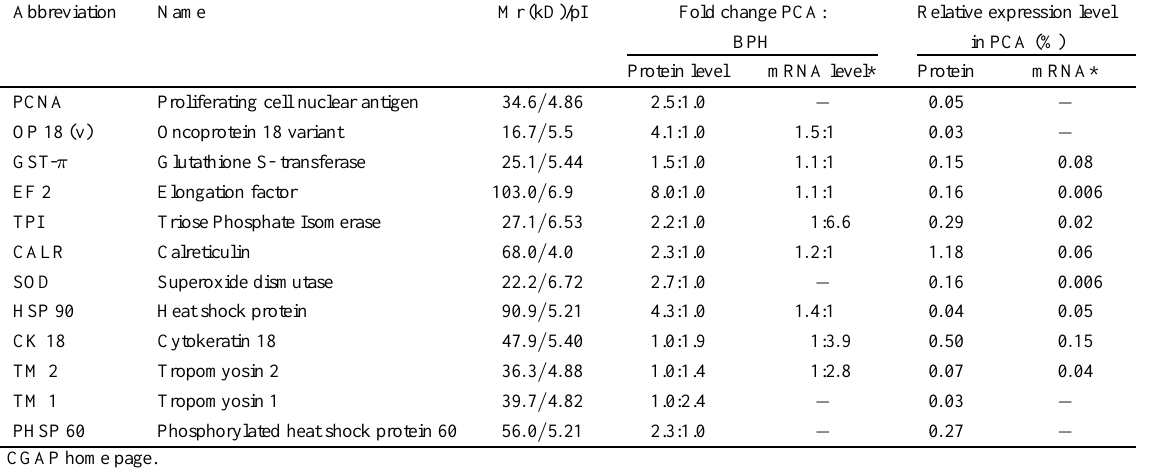
Protein and mRNA expression levels in selected analysed polypeptides with known identity